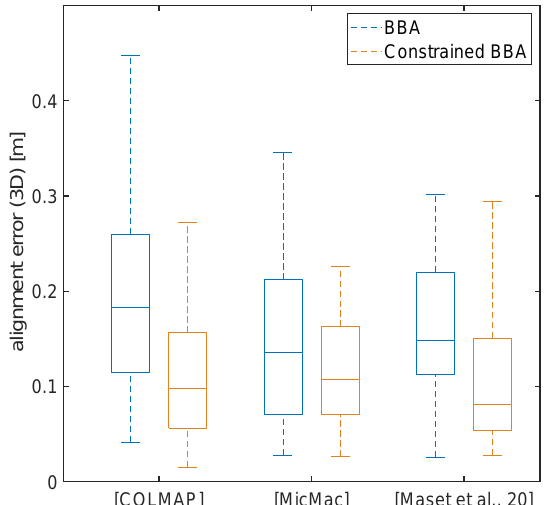
Figure 4. Results of the comparison experiments for the Leica CityMapper dataset between the unconstrained (blue bars) and constrained (orange bars) bundle adjustments. Altimetric component of object-space errors for GCPs,